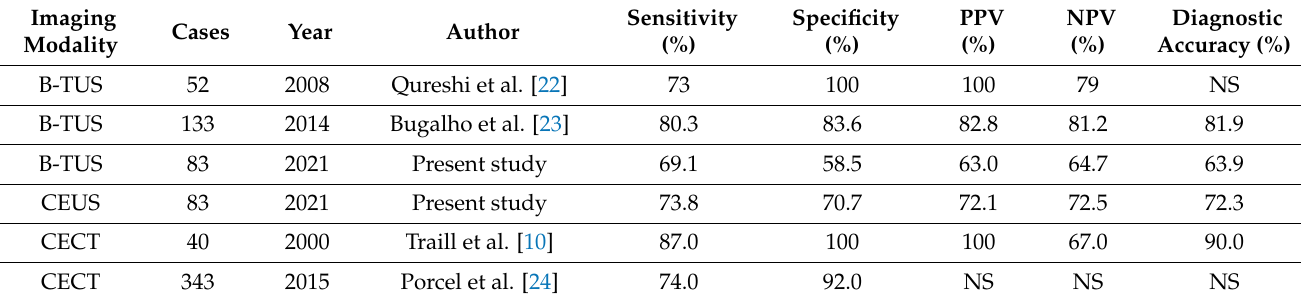
Table 6. Diagnostic performance of B-TUS, CEUS, and CECT for evaluating PE malignancy. Imaging